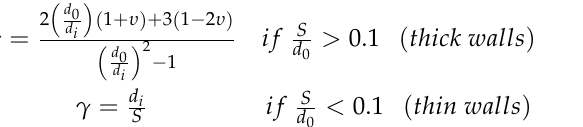
Figure 13. Equivalent fluid density. The experimental average air and water superficial velocities measured in the flow loop are used to calculate the GVF. The updated equivalent fluid parameters are used as model inputs for the Low-D model for cases 1–3 (Table 3).